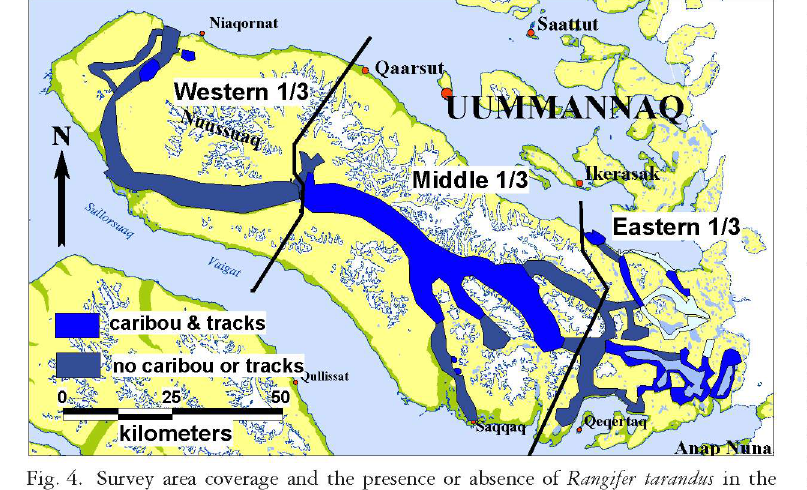
Fig. 4. Survey area coverage and the presence or absence areas surveyed on the Nuussuaq Peninsula in April of the animals could not be aged due to within group animal movement, which confounded identification, combined with too great a distance between observer and animals. All 87 were in an area where observa tions included primarily females with calves. Given the known numbers of adults (753), the true late winter calf percentage was 30.1% and calf recruit ment was 43 calves per 100 adults, or similarly, 73 calves per 100 cows (443). Given the known number of bulls (143) and cows (443), there were just over 3 females for every bull for a bull to cow ratio of 0.32. Average group size was small in the middle third of the peninsula (Table 2), but large in the eastern third, which included tightly cohesive groups of 63, 206 and 212 animals. Similarly, density was greatest in the eastern third. Body condition was subjectively ascer tained as prime. All animals appeared well rounded and not a single animal showing ribs was observed. Phenotypic variation Average group size and density were not the only notable differences between the animals inhabiting the middle versus the eastern third of the peninsula. Adult females in the eastern third possessed antlers, and even many female calves were antlered (Table 3). Whether single or paired, antlers were well formed, with no raggedy remnants of velvet. Antlers among females in the middle third were not common. Fur¬ ther, the animals in the middle third were always a pale gray-white color. In contrast, the animals in the eastern third were typically dark, with some being a deep brown. Further, calves in the middle third were noticeably smaller than those observed in the eastern third. The latter were almost adult in size and often possessed paired antlers with several